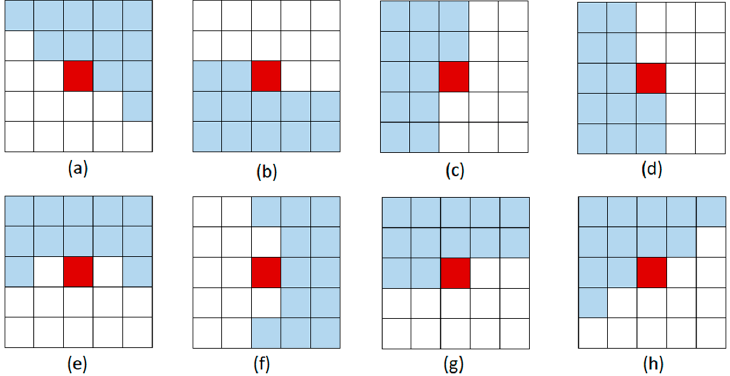
Figure 7. Eight different edge scenarios, where white pixels represent the X region and blue pixels represent the Y region in the mask.